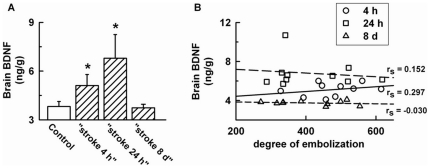
Brain BDNF levels after stroke.A) brain was collected in control rats (empty bars, 7 rats) and in the “stroke 4 h”, “stroke 24 h”, and “stroke 8 d” groups (dashed bars, 10 rats per group), B). Scatter plot between levels of BDNF in individual brains and degree of cerebral embolization. Data are expressed as mean ± SD, * significantly different from control rats (p<0.016), rs = Spearman's rank correlation coefficient.